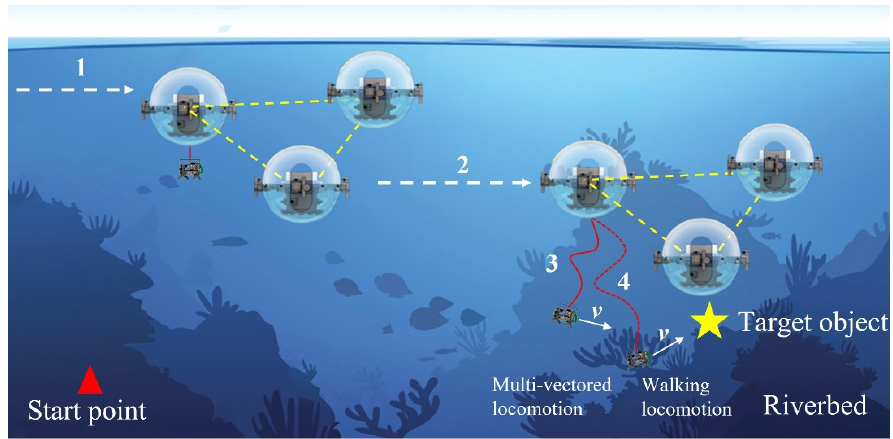
Figure 1. Schematic of the operation principle of the father – son underwater robot.